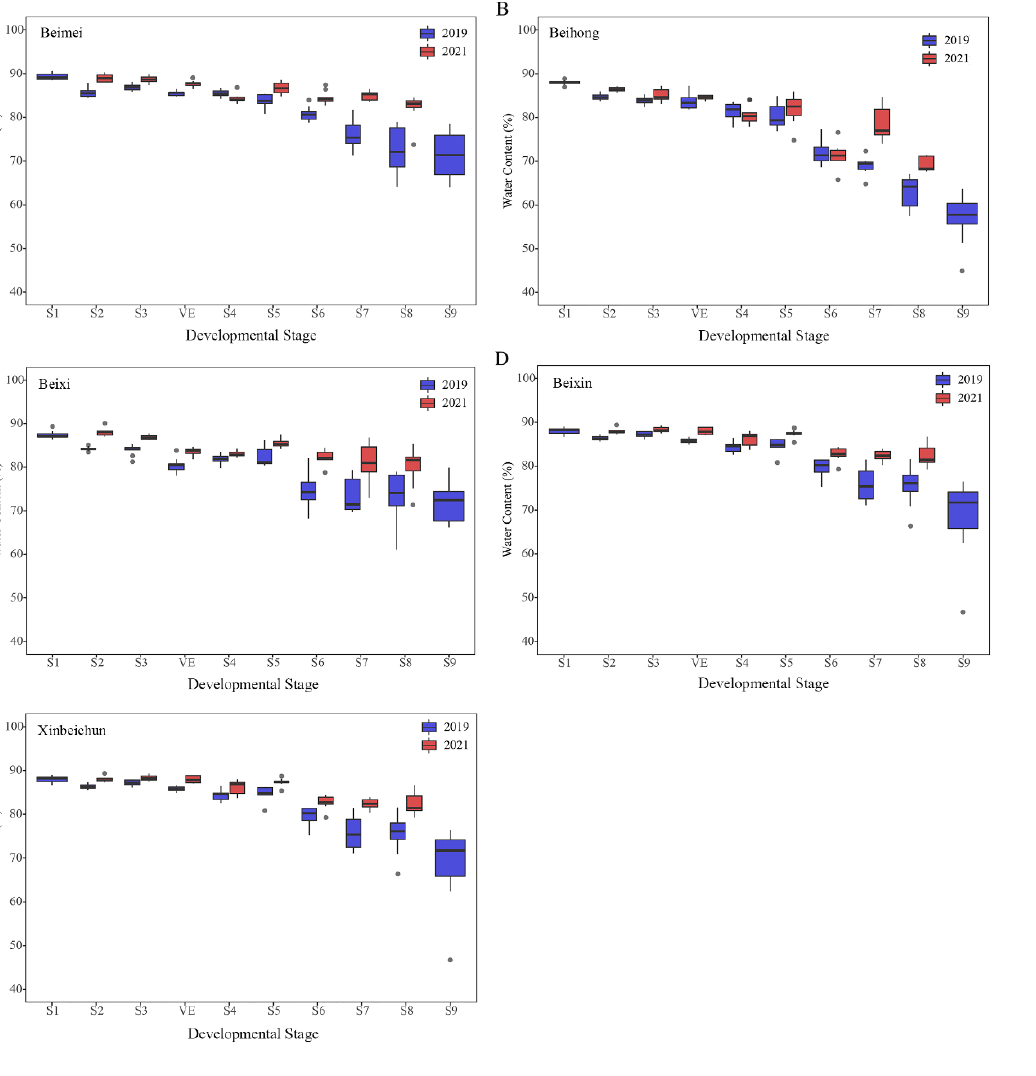
Figure 4. Water content changes at different development stages in ’Beimei’ ( A ), ‘Beihong’ ( B ), ‘Beixi’ ( C ), ‘Beixin’ ( D ) and ‘Xinbeichun’ ( E ). S1 sampling date was 19 June 2019. S2 sampling date was 2021 is 8 July. S1 – S9 were sampled once every two weeks, VE = veraison. Data are mean values of nine repeats.